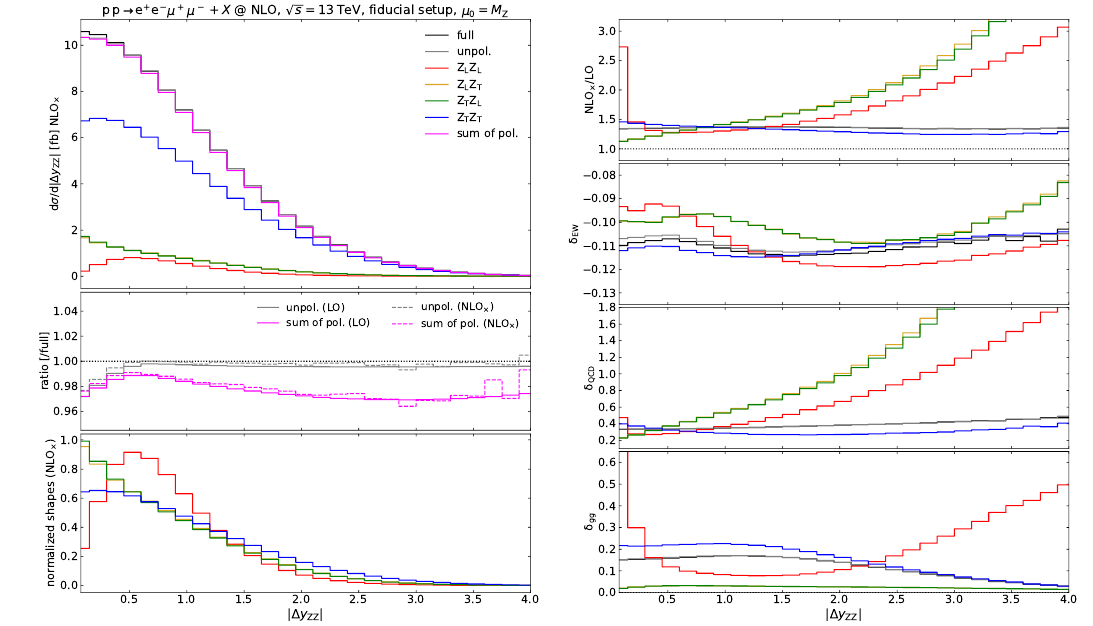
Figure 17 . Distributions in the absolute value of the rapidity separation between the two Z bosons. Same structure as in figure